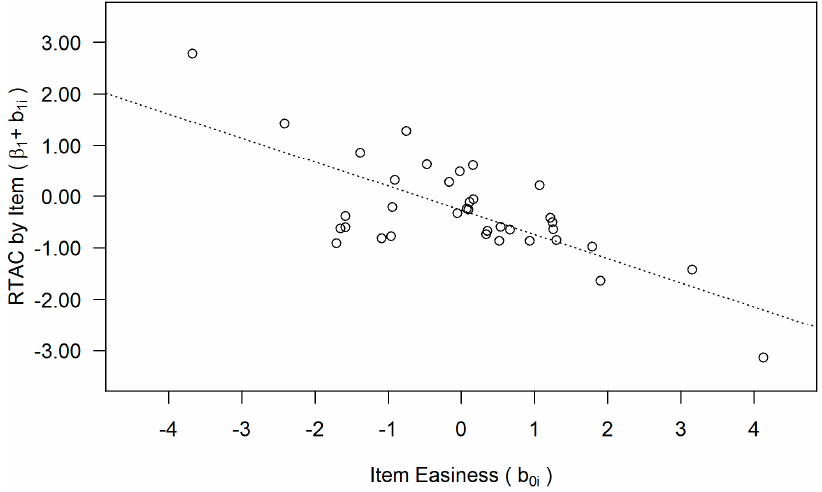
Figure 5. Item RTAC by item easiness.